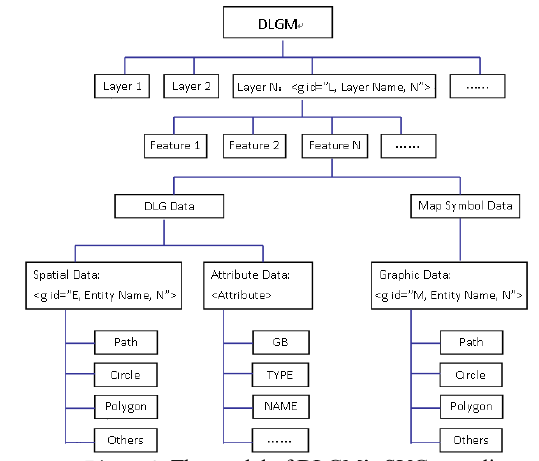
Figure 6. The model of DLGM’s SVG encoding